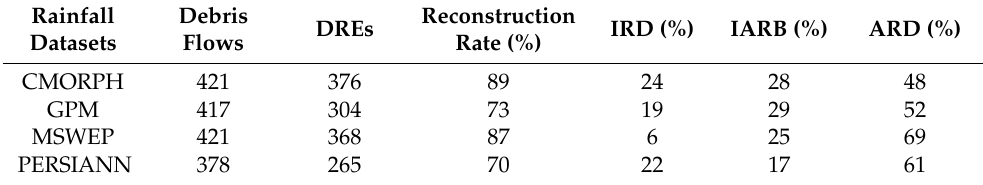
Table 3. Summary of rainfall event reconstruction for DREs and different rainfall